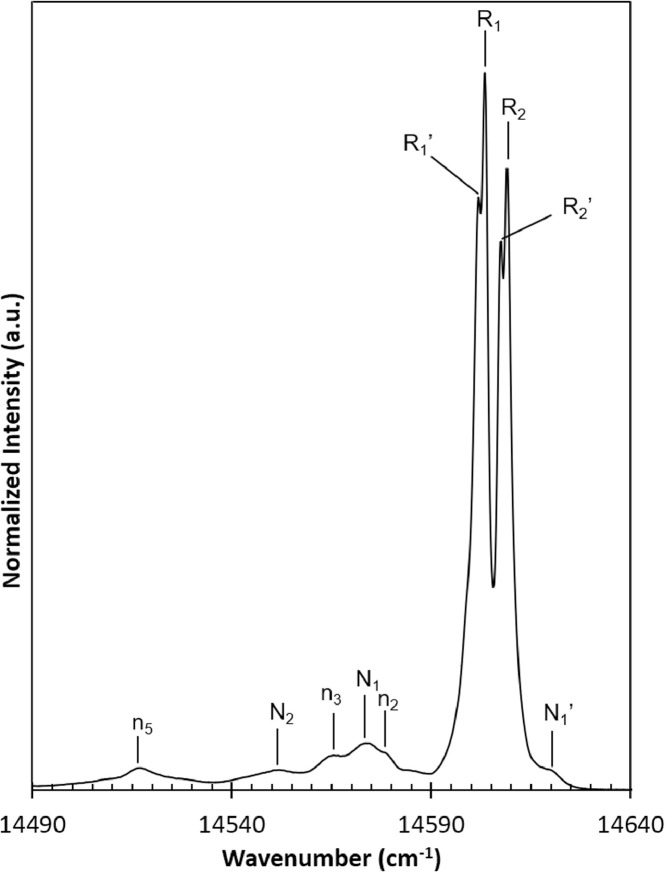
PL spectra of unheated natural MgAl2O4 spinel.